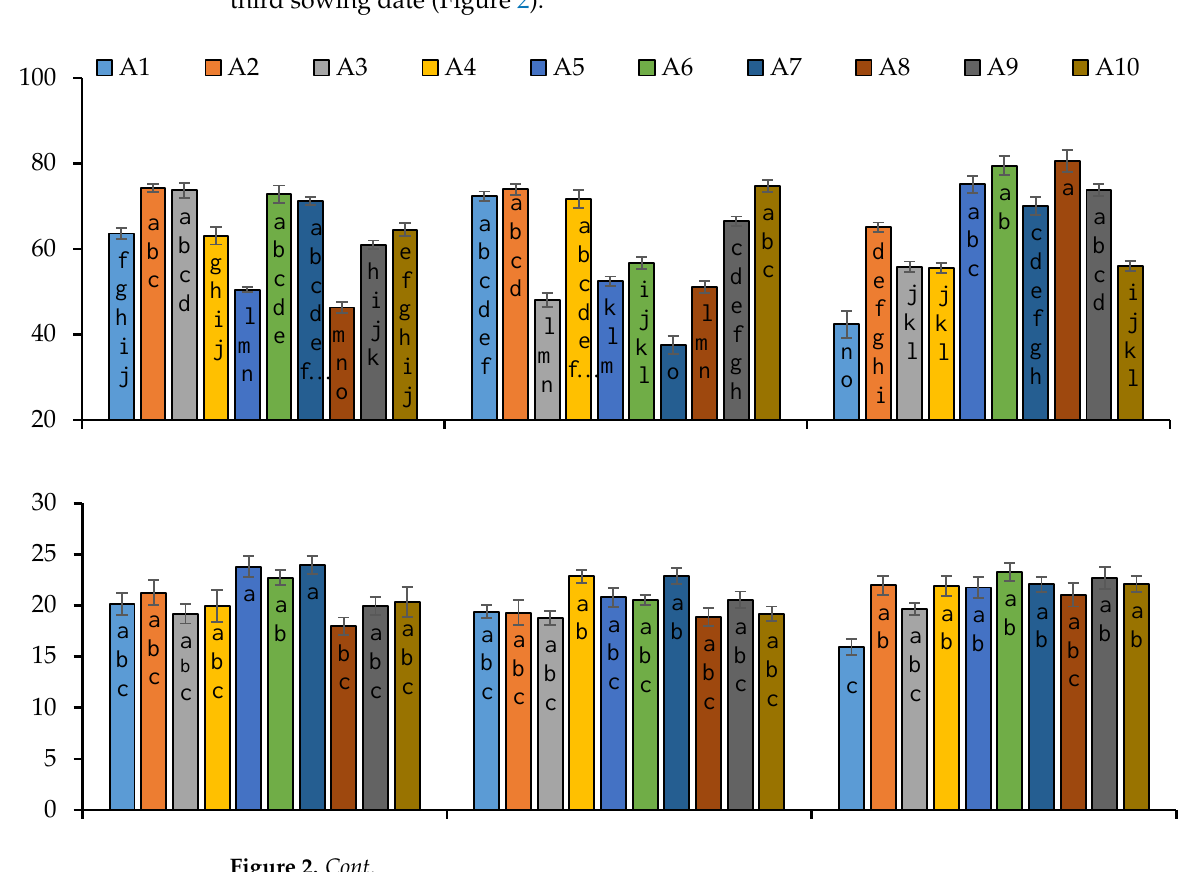
Figure 1. Emergence percentage and days to anthesis of quinoa lines grown under varying sowing dates. Bars sharing the same alphabet did not differ significantly at p < 0.05. Small alphabets (a, b, c. etc.) are used to express the statistically significant difference.